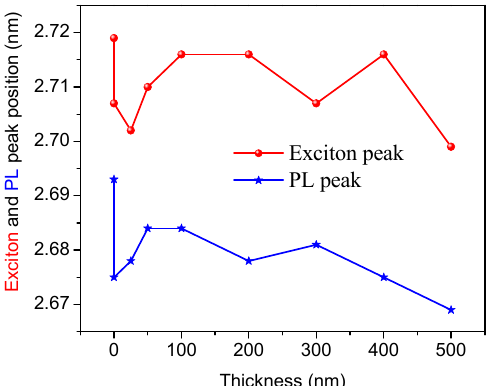
Figure 6. Exciton and photoluminescence (PL) peak positions of perovskite thin films versus the polymethyl methacrylate (PMMA) thickness.